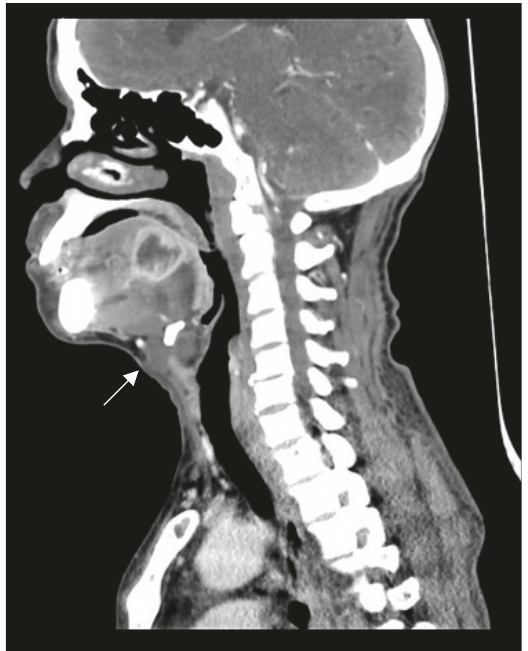
Figure 3: Contrast-enhanced CT scan demonstrated an abscess at left posterior tongue with thyroglossal duct cyst (arrow) was also identified without feature of rim